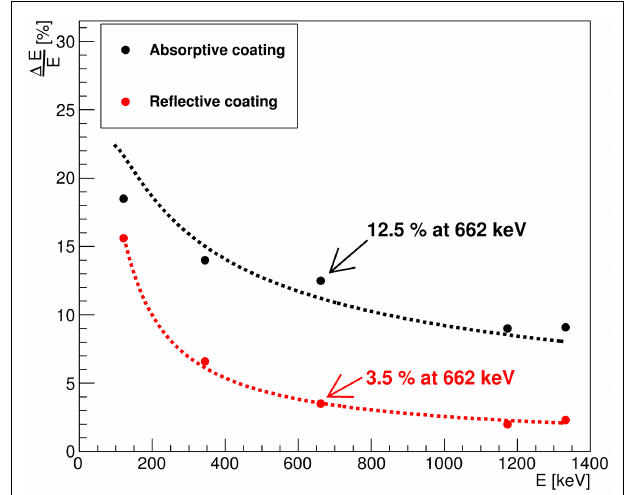
FIGURE 1 | Energy resolution as a function of the photon energy values measured by a LaBr 3 :Ce detector with reflective (red) and absorptive (black) side surface coating obtained with 152 Eu, 137 Cs, and 60 Co calibration sources . The dotted lines represent a two-parameter function fit as indicated in Equation